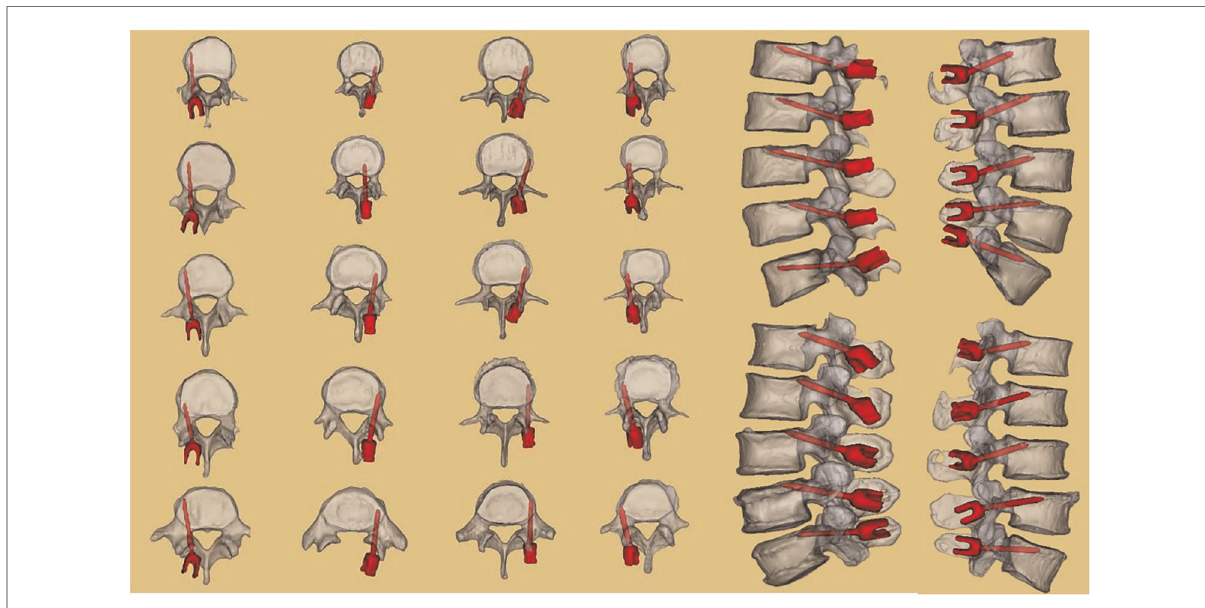
FIGURE 3 CT scan results of the four human anatomical specimens after screw placement. Twenty screws were placed in the four anatomical specimens under the aid of 3D-printed navigation templates. CT scans and three reconstructions were performed to observe screw placement. One screw was placed with an undesirable